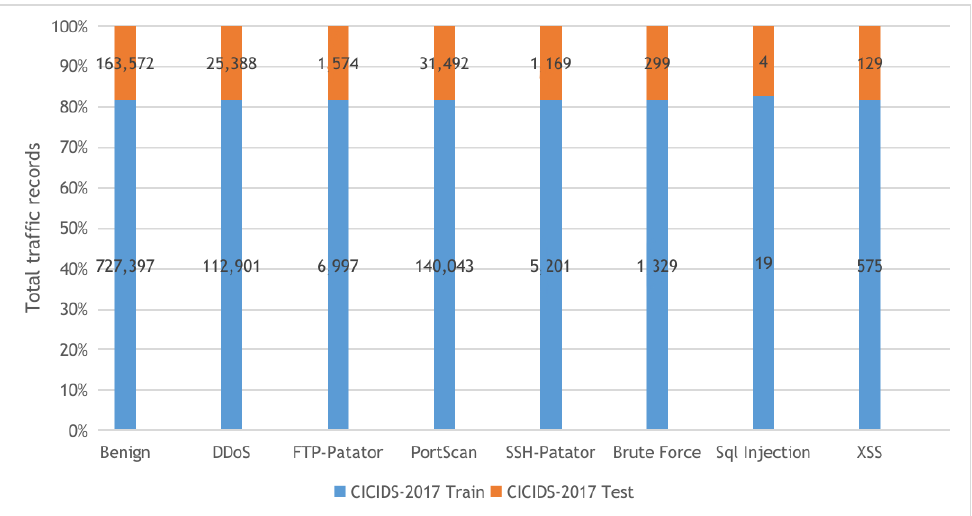
Figure 6. The CICIDS-2017 dataset training and testing sets